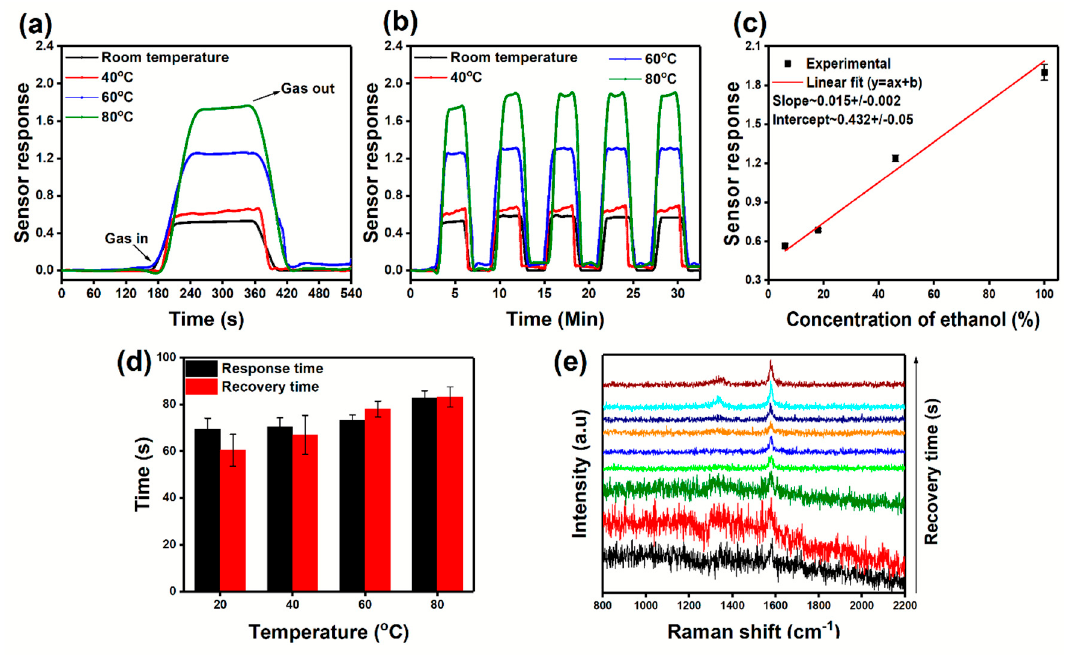
Figure 7. Gas sensor properties of OCNs prepared from RF gel: ( a ) sensor response to ethanol vapor at different heating temperatures, ( b ) repeatability of sensor response towards ethanol vapor; ( c ) sensor response towards the ethanol concentration as a function of heating temperature; ( d ) response and recovery time of OCN-based sensors towards ethanol at different heating temperature; and ( e ) ex-situ Raman spectra recorded on OCN sensor during the recovery of ethanol after sensor response at an acquisition time of 4 s with an interval of 6 s.